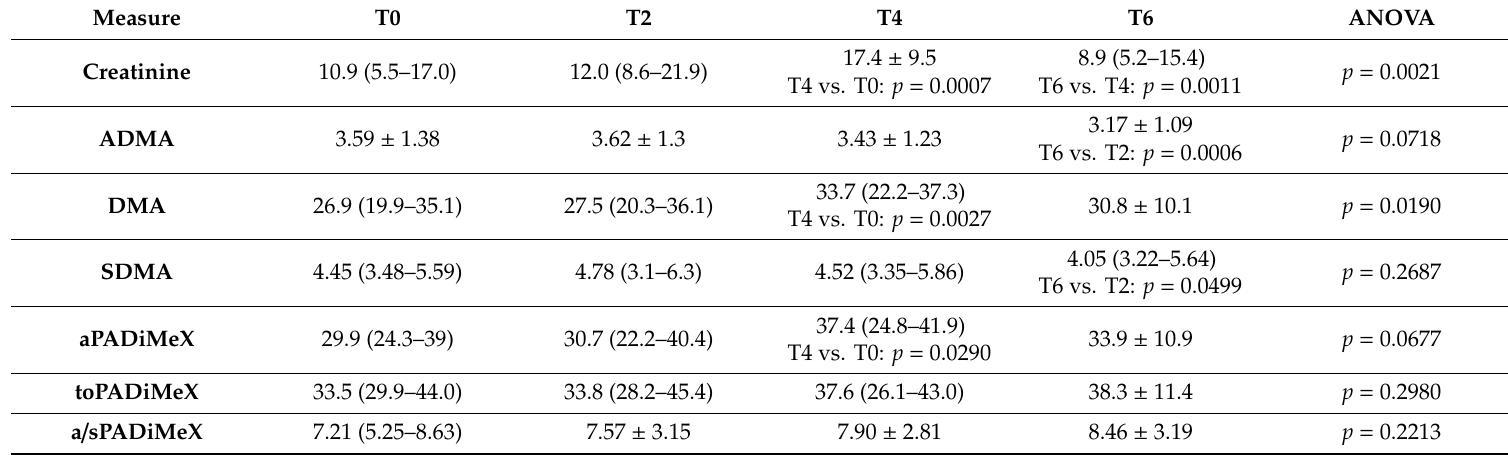
Table 4. Urinary creatinine (mmol / L), creatinine-corrected excretion of ADMA, DMA, SDMA, aPADiMeX, toPADiMeX ( µ mol / mmol), and a / sPADiMeX (median (25th–75th) or mean ± SD) at the indicated time